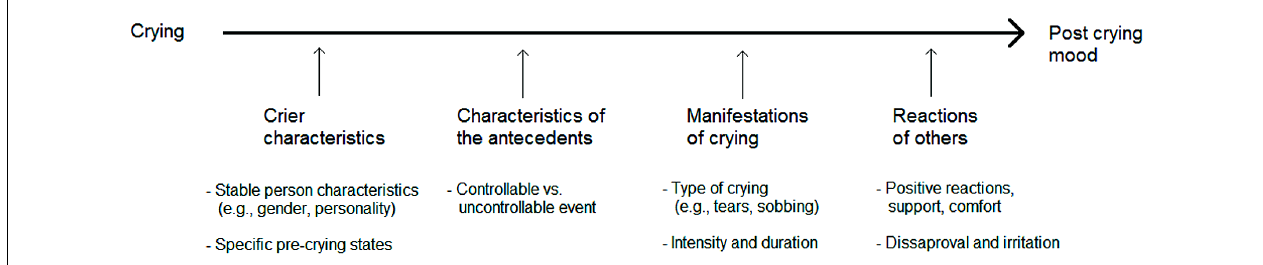
FIGURE 2 | Moderators of the effects of crying on post-crying